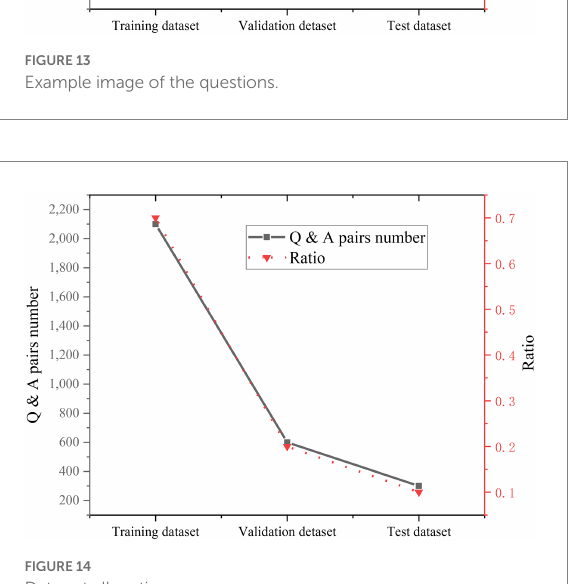
FIGURE 14 Data set